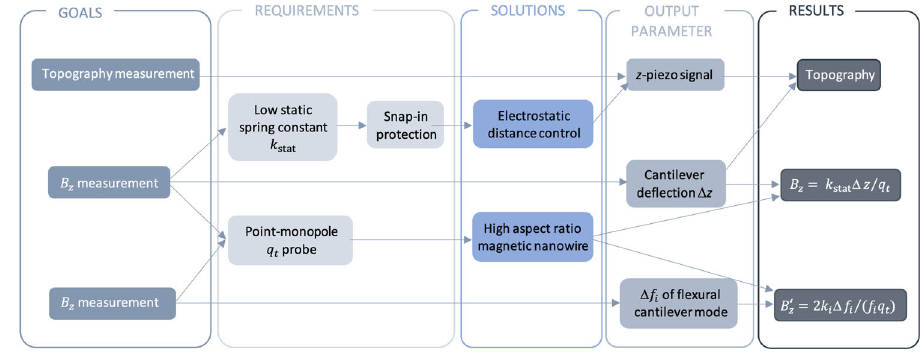
Fig. 1 Concept map. Concept map of combined fi eld and fi eld gradient microscopy as proposed and employed in this publication. Here, k stat , 4 z , k i , f i , 4 f i , and q t are the cantilever ’ s static spring constant, the cantilever de fl ection, the spring constant of the i -th fl exural vibration mode, the resonance frequency of the i -th fl exural mode, the corresponding resonance frequency shift, and the monopole-like magnetic tip moment.